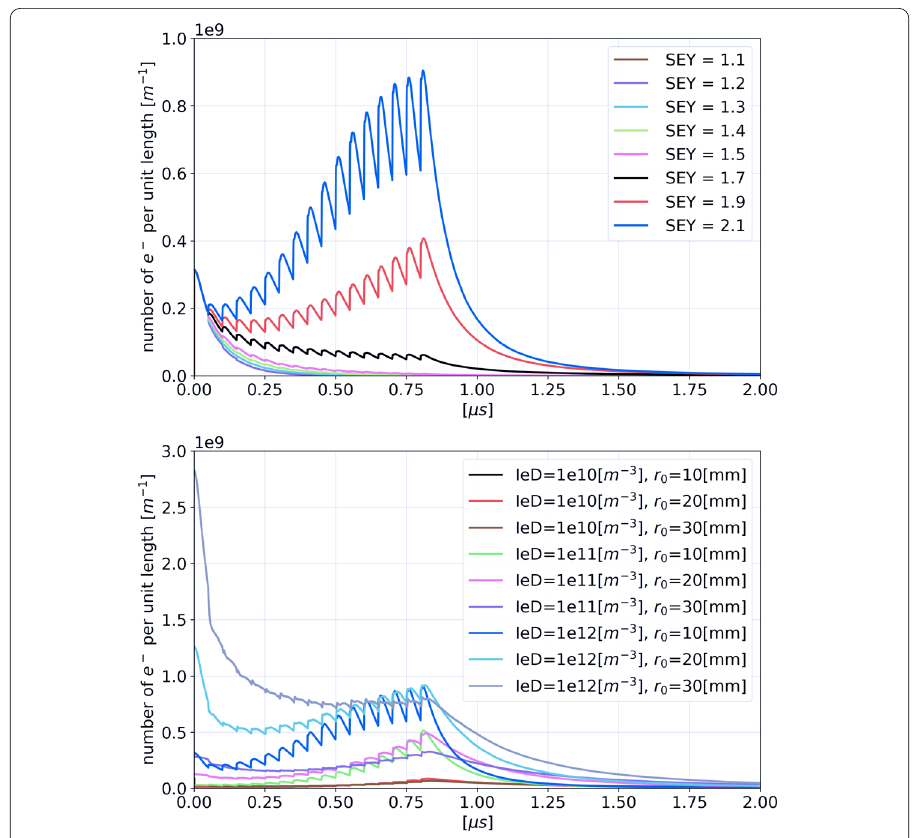
Figure 2 Simulated electron-cloud evolution from an initial uniform seed for DR injection, using the Furman–Pivi model. 16 bunches with 50 ns spacing are followed by a gap. Upperfigure : r 0 = 10 mm and IeD = 10 12 m –3 , lowerfigure : SEY = 2.1